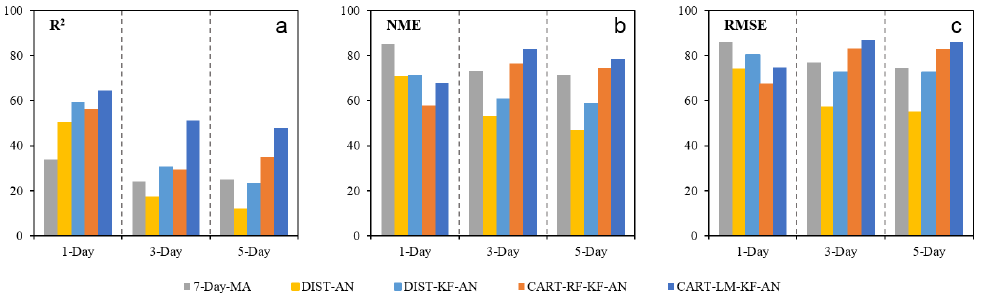
Figure 5. Percentage (%) of avg-monitors with increased R 2 values ( a ), and decreased NME ( b ) and RMSE values ( c ) by the five post-correction methods and for the 1, 3, and 5-day lead times.